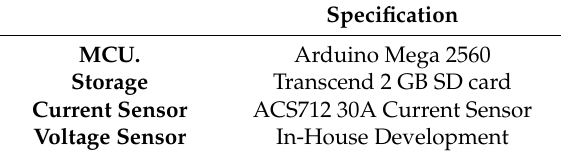
Table 2. Specifications of the PPRS.